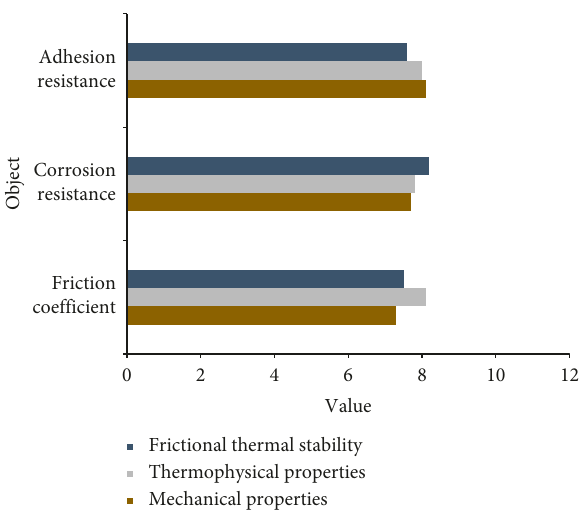
Figure 6: Performance analysis of powder metallurgy materials.